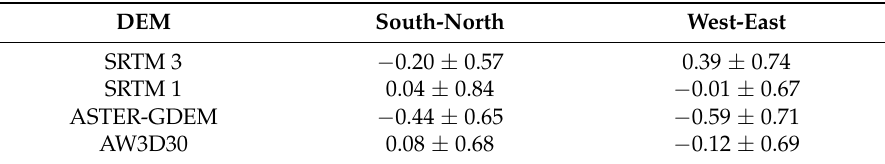
Table 2. Horizontal errors (in pixels, 1 pixel = 25 m) after co-registration between the assessed DEMs and the reference